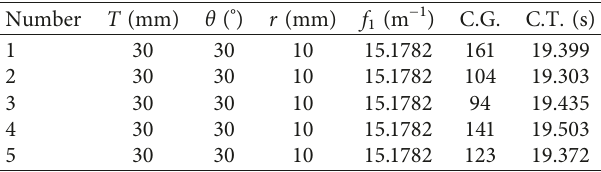
Table 3: Results obtained by